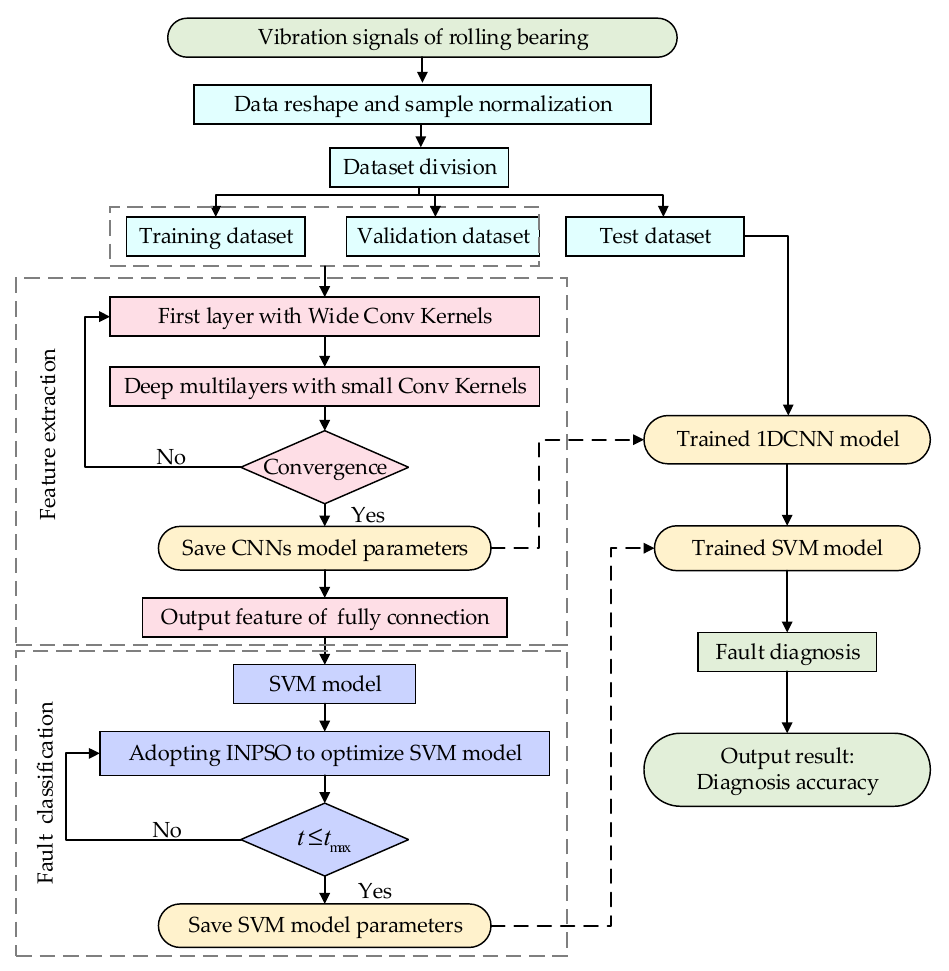
Figure 1. The framework of the proposed one-dimensional convolutional neural network improved novel particle swarm optimization support vector machine (1DCNN-INPSO-SVM) intelligent fault diagnosis method.